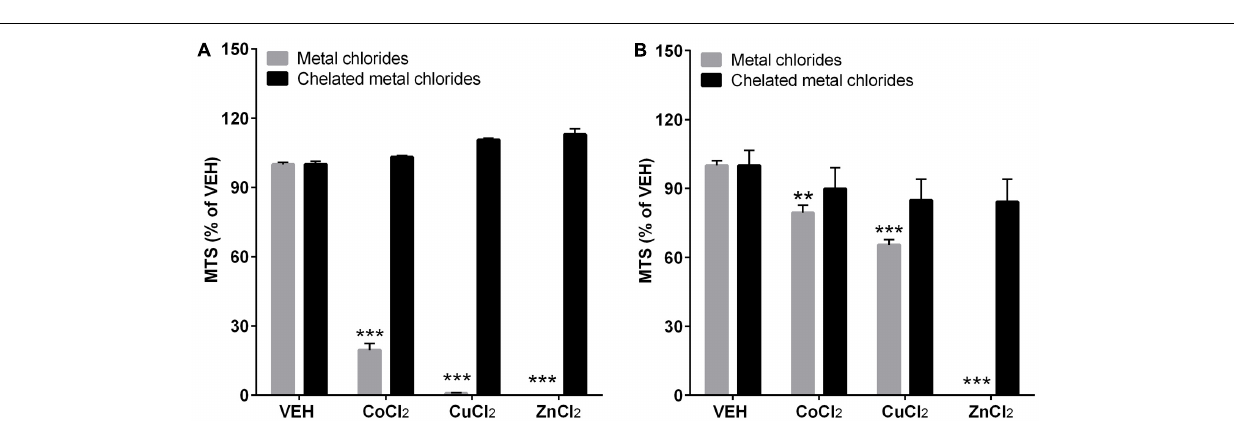
chlorides (CoCl 2 , CuCl 2 , and ZnCl 2 ) also showed no biologically meaningful changes in the IL-8 levels, although ZnCl 2 showed slight increases in the low and mid dose ( Figure 5